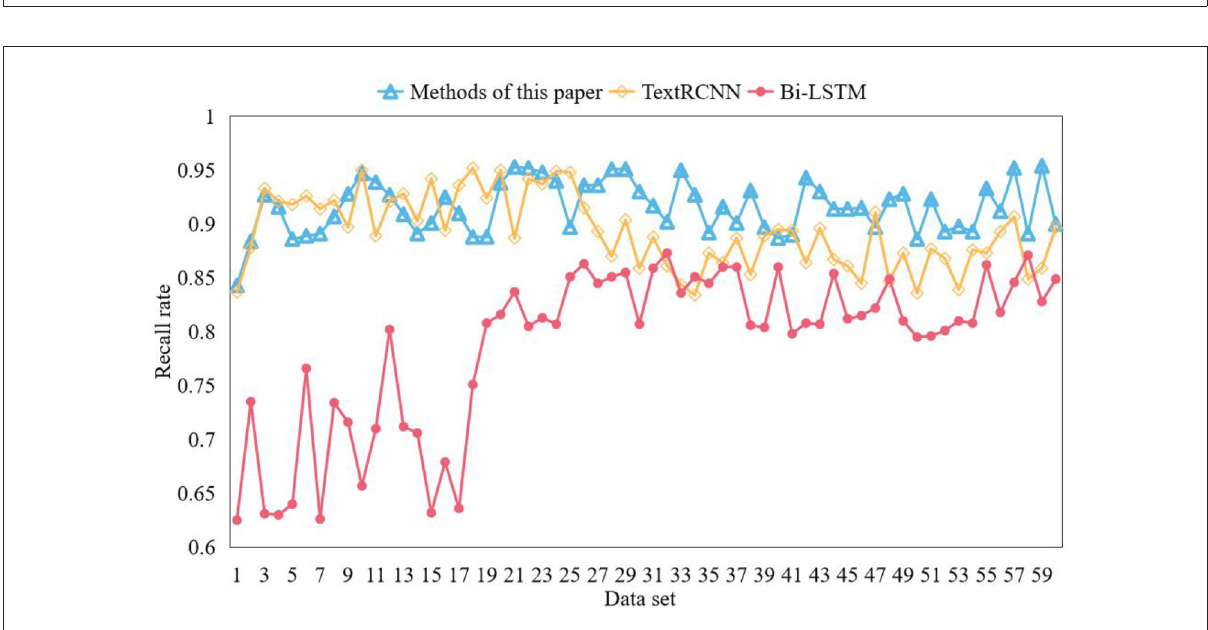
FIGURE8 Comparison of recall rates of